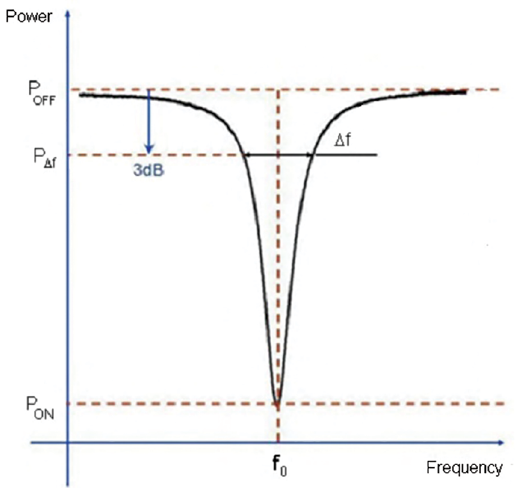
Figure 3. Reflection curve at